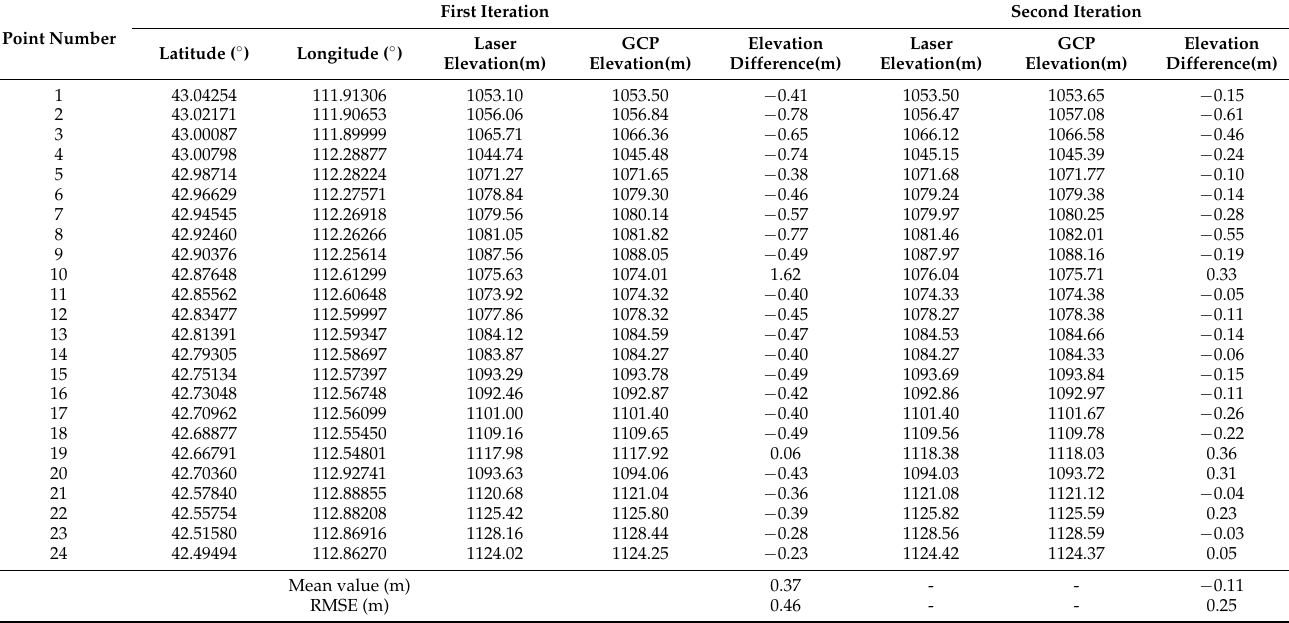
Table 5. The elevation accuracy of GF-7 laser beam 2 after iterative calibration based on